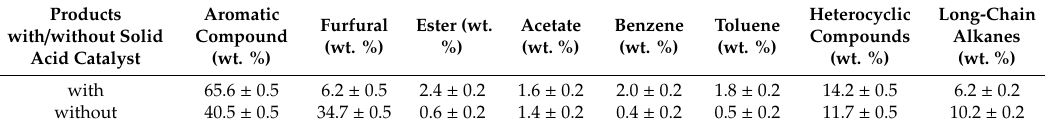
Table 4. Products of hydrothermal reaction of lignin degradation with and without solid acid catalyst. Products with / without